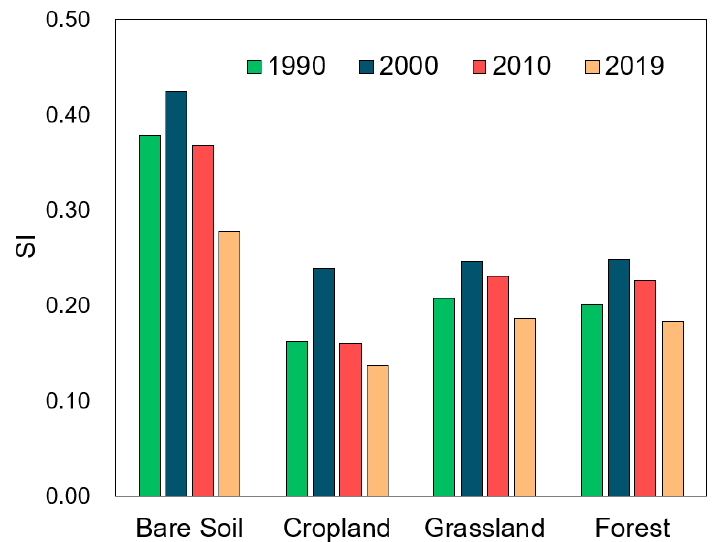
Figure 10. Mean values of the salinity index (SI) for land use types over the study period.